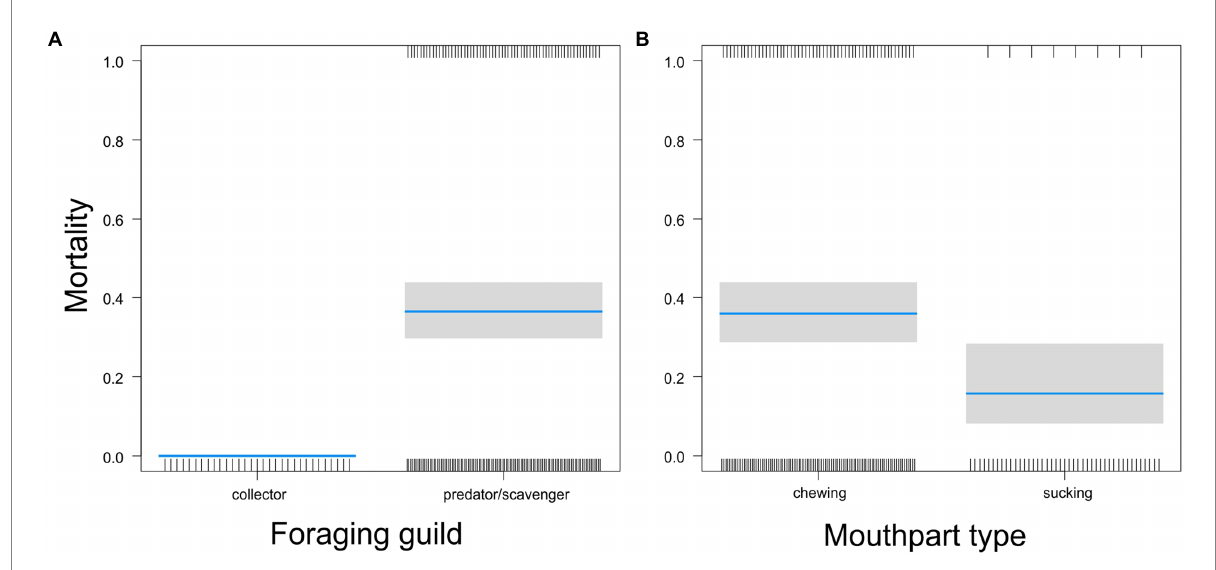
FIGURE 6 Comparison of the mortalities of pupas protected by webs between predators from different guilds (A) or possessing different mouthparts (B) . Blue lines are estimated means, gray bars are 95% confidence intervals of the mean. Marks on the horizontal axes represent surviving (upper axis) or dead individuals (lower